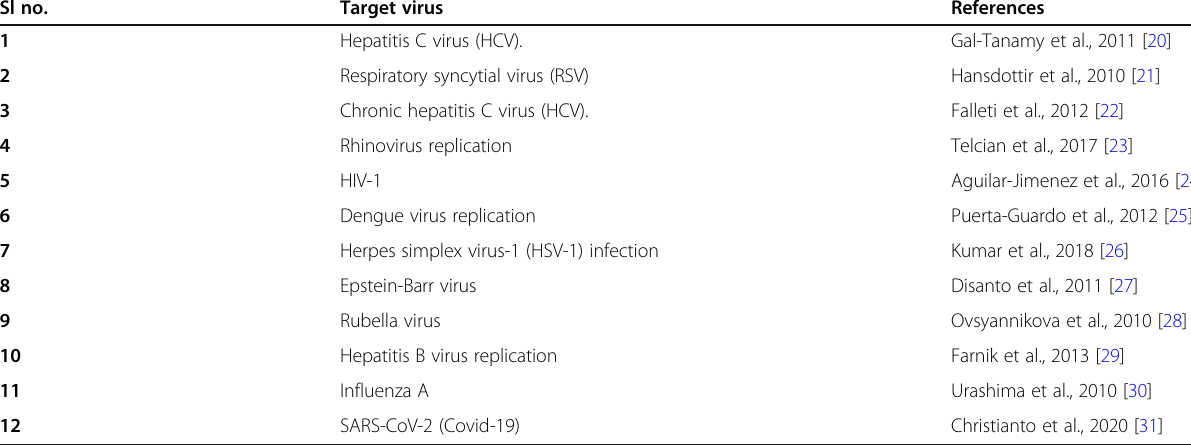
Table 1 List of viral pathogens evidenced for anti-viral feat by the consequence of Vitamin D Sl